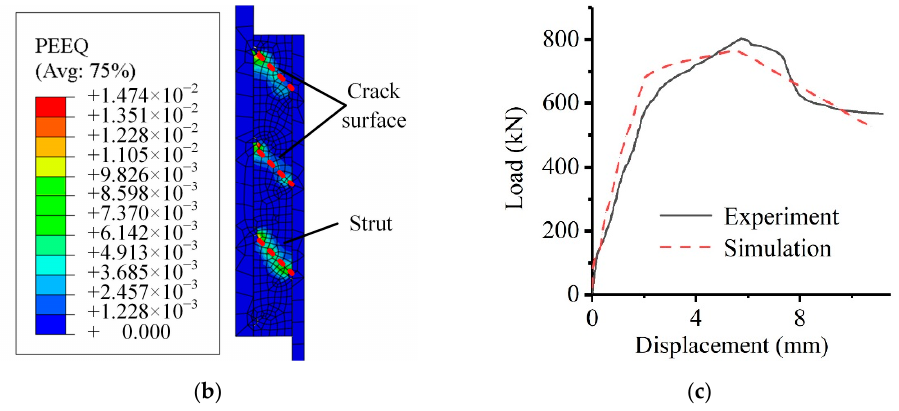
Figure 12. Finite element analysis of B3: ( a ) model of B3; ( b ) strain in the sleeve grouting connection; ( c ) load–displacement curve.